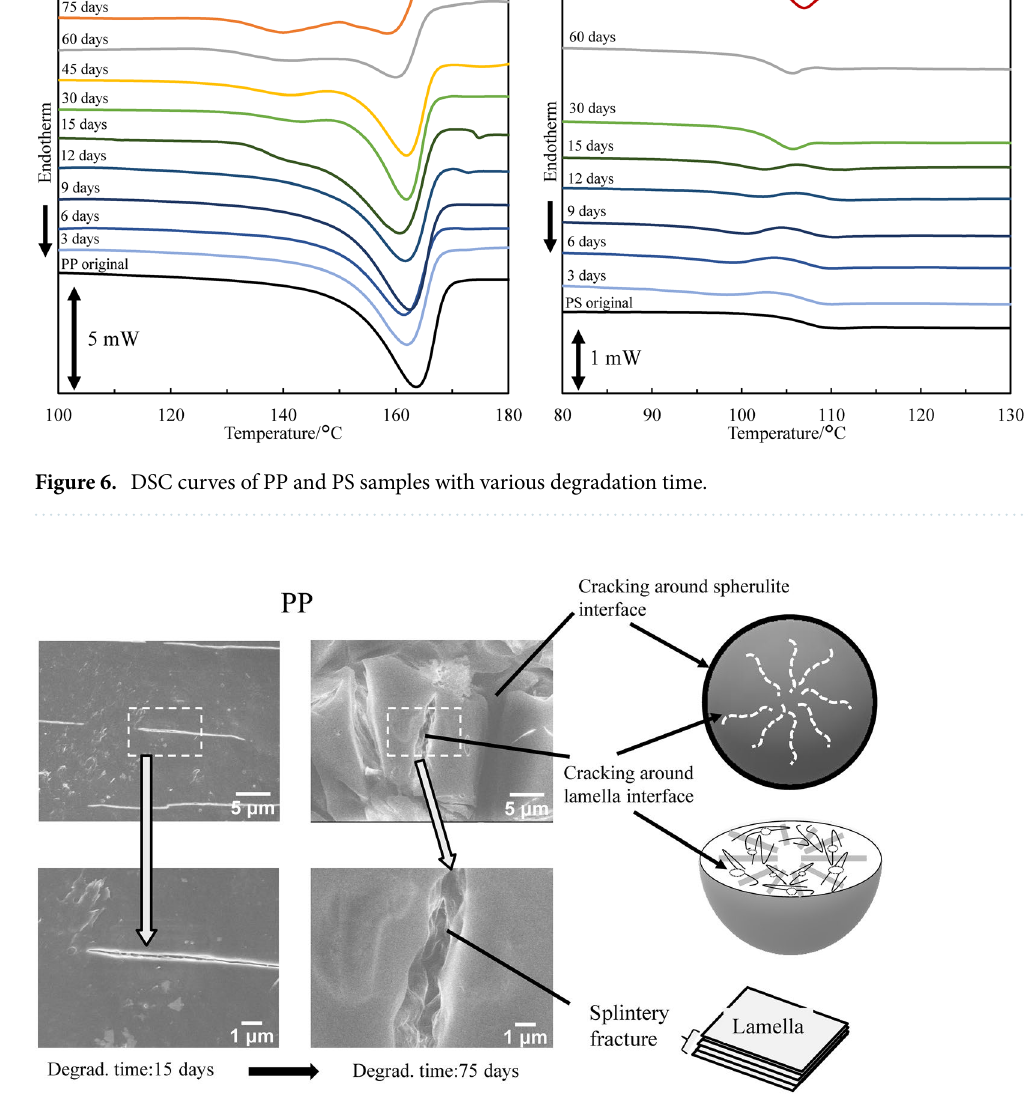
Figure 7. SEM photographs and cracking locations of PP in